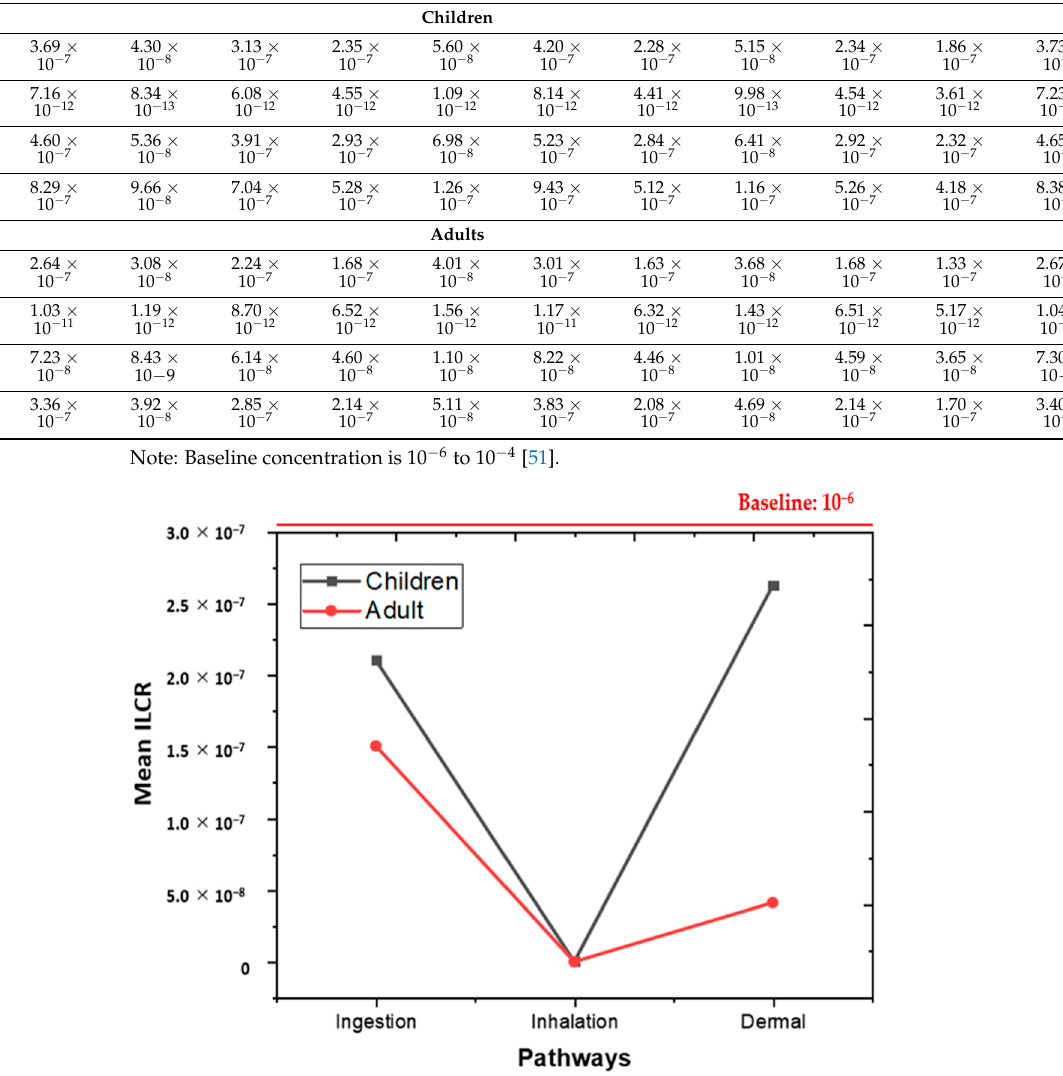
Figure 8. The estimated mean ILCRs that PAHs in street dust pose to children and adults.